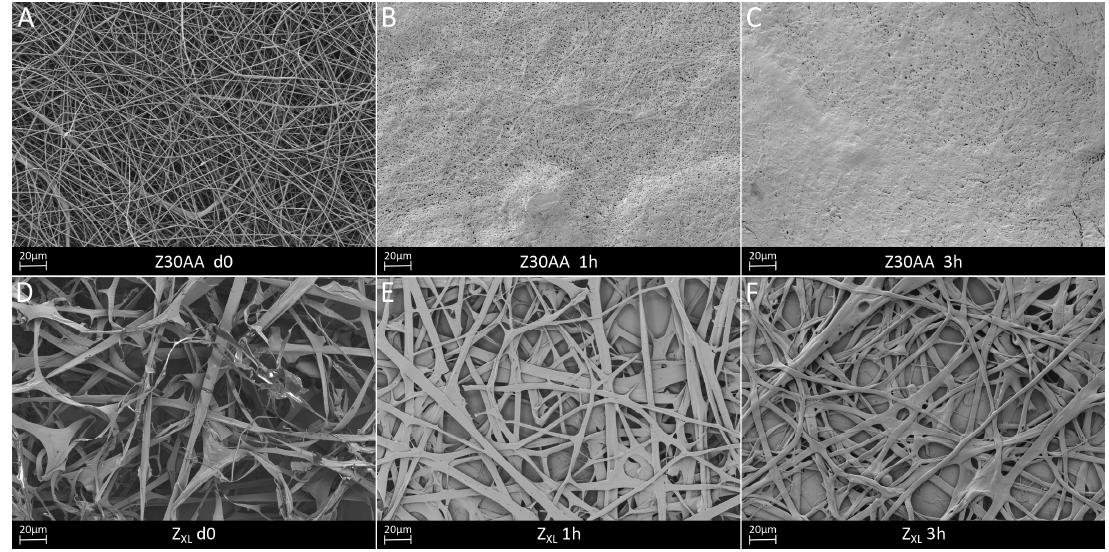
Figure 8. SEM micrographs of uncross-linked Z26E fiber mats ( A – C ) and EDC/NHS cross-linked Z XL fiber mats ( D – F ) before and after 1 and 3 h of PBS incubation.